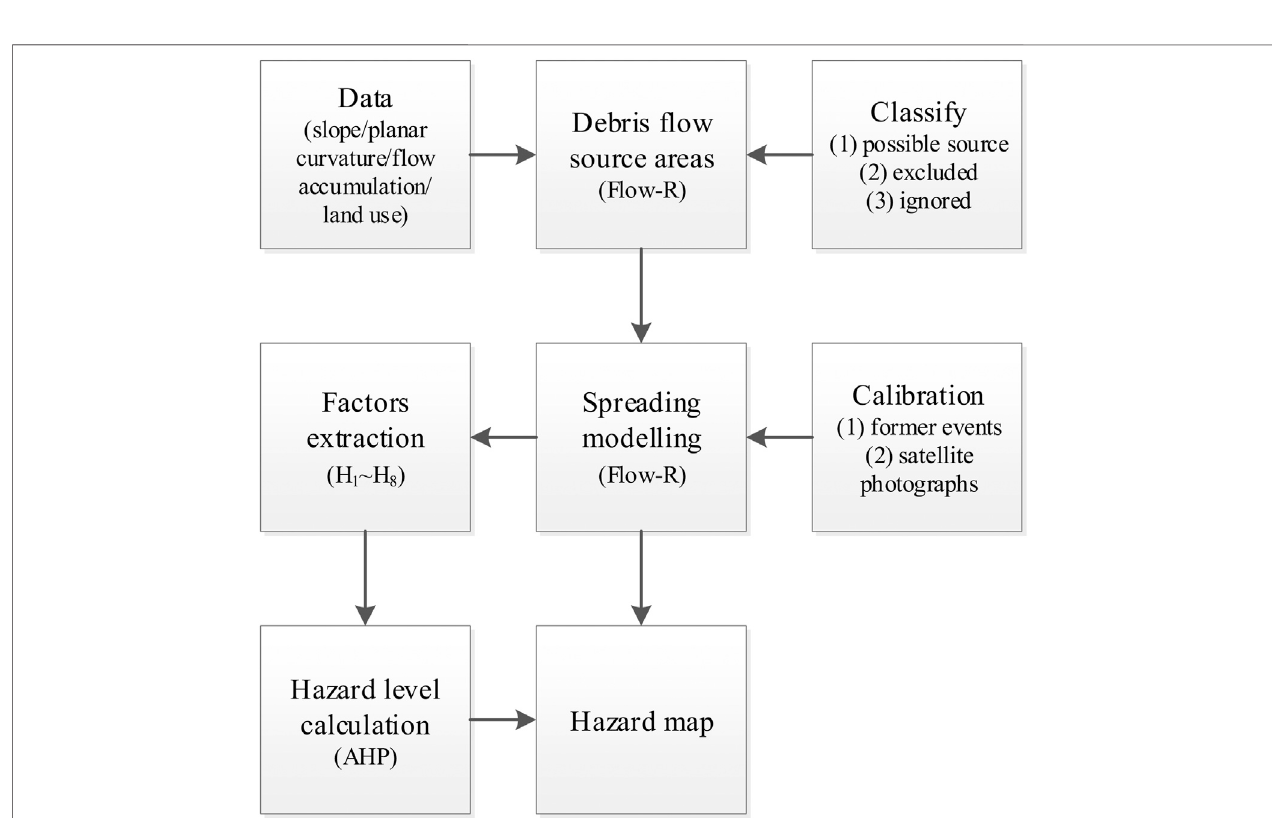
FIGURE 2 | Work fl ow chart.